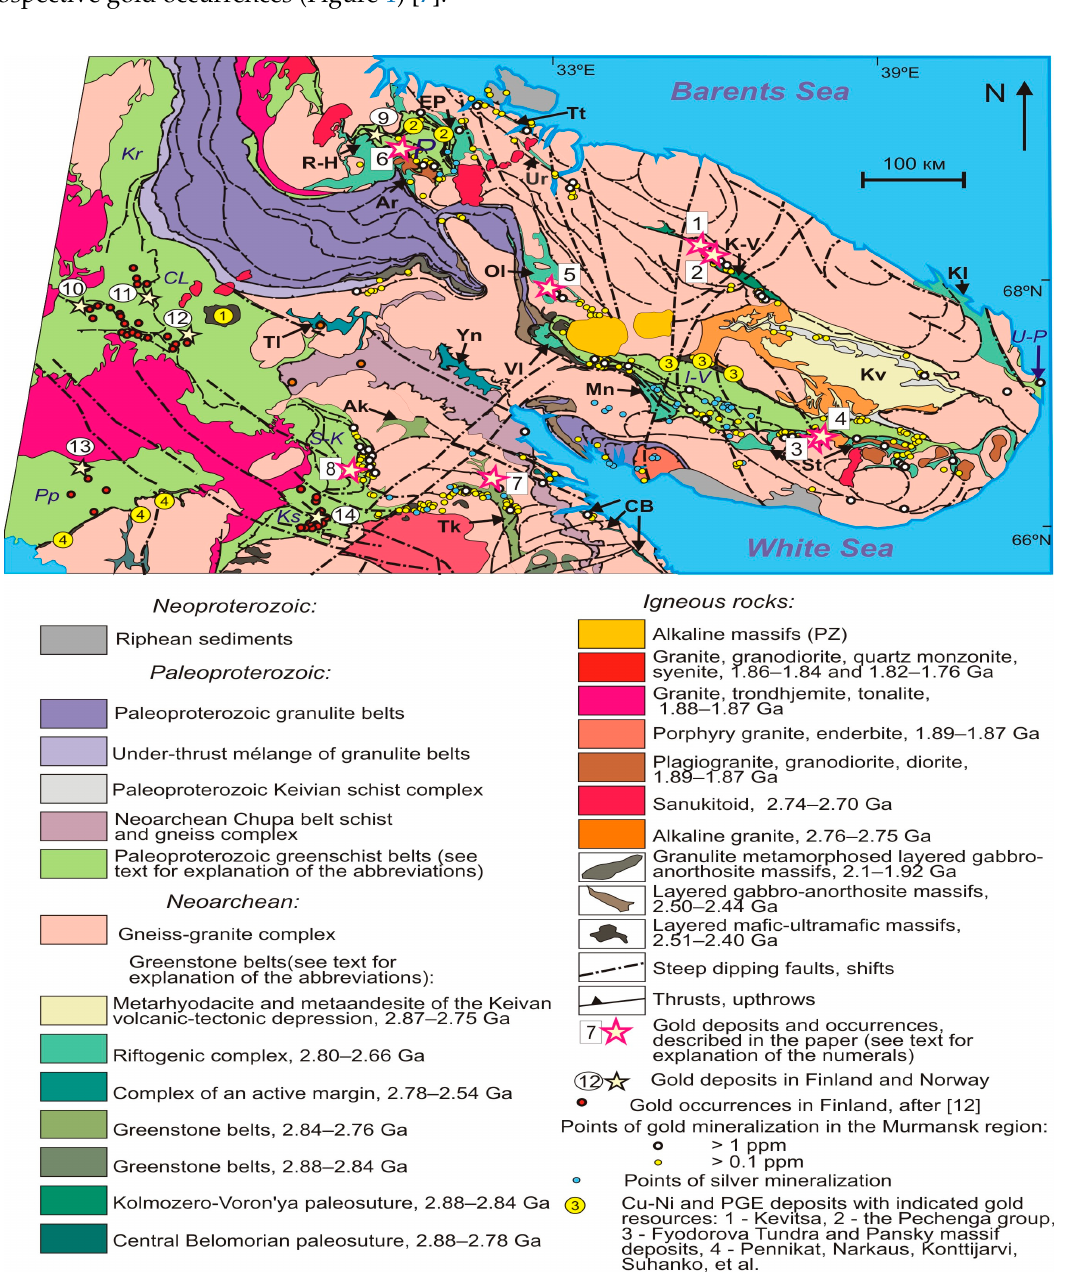
Figure 1. Schematic tectonic–geological map (modified from Reference [8]), showing the locations of greenstone belts and gold mineralization in the northeastern part of the Fennoscandian